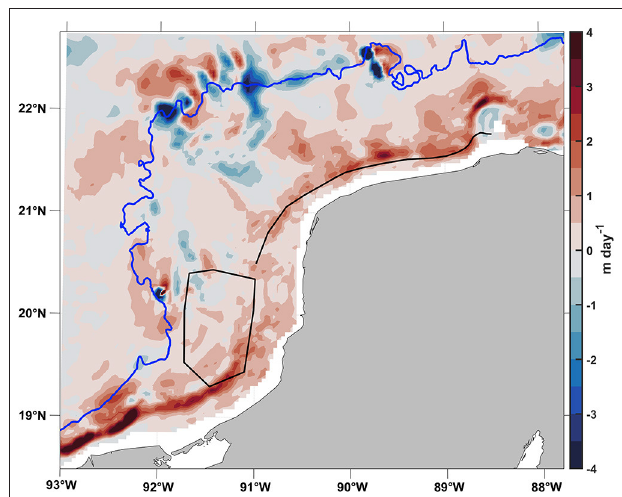
FIGURE 11 | Vertical velocity (mday − 1 ) from HyCOM GoM, time-averaged June 10, 2018, through July 19, 2018, and depth-averaged between 5 and 50m, or bottom when < 50m. The 50m isobath is shown in blue; the polygon used for initial trajectory positions, and a representative trajectory (see Figure 10 ) are shown in